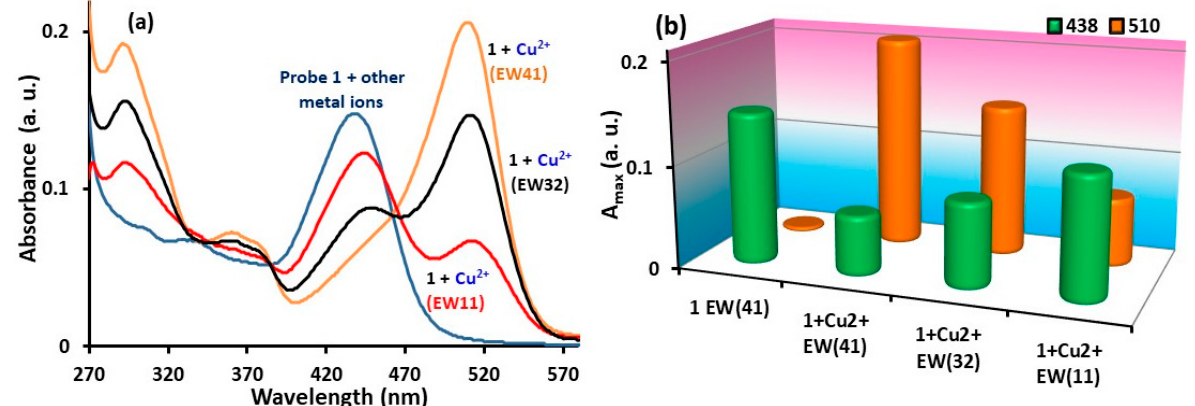
Figure 1. Effect of water content on Cu 2+ sensing of probe 1 (10 µM, EtOH). ( a ) UV-vis spectra of probe 1 with increasing water content in EtOH from 0% (i.e., EtOH only) to 50% water and ( b ) associated bar diagram of the absorption maximum value before ( A 438 ) and after addition of Cu 2+ ( A 510 ). ‘E’ and ‘W’ represent ethanol and water, respectively, and the numbers indicate the ratios of ethanol and water .